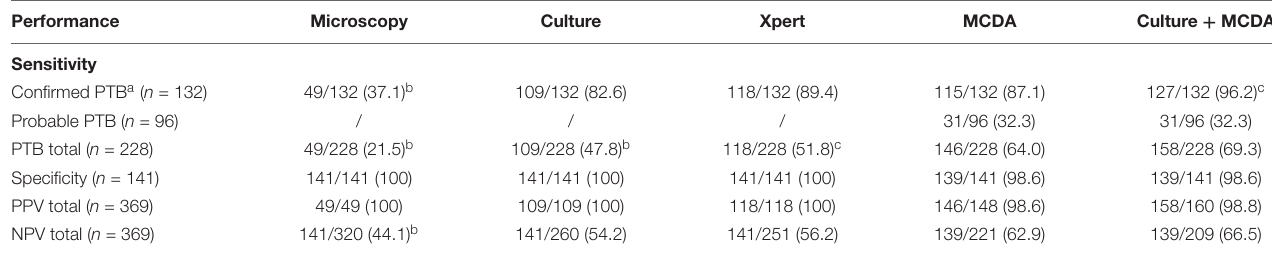
TABLE 2 | Diagnostic accuracy of different methods in the pulmonary TB